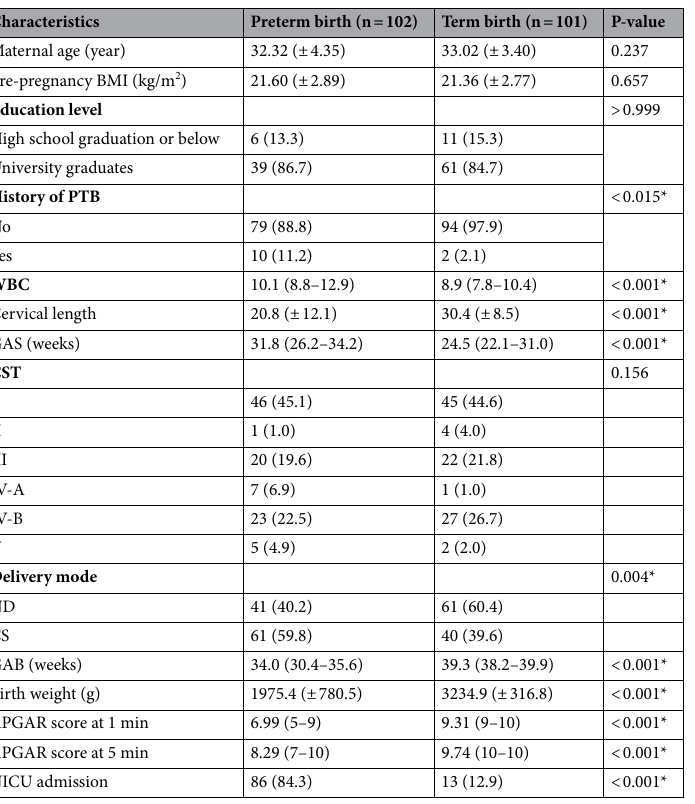
Table 1. Clinical characteristics of the study subjects. Categorical variables were expressed as frequencies (percentage) and analyzed using the chi-square test and Fisher’s exact test. Continuous variables were expressed as the mean ± standard deviation (SD) or median (interquartile range) and were compared using the t -test or Mann–Whitney U test. BMI body mass index, PTB preterm birth, WBC white blood cell, GAS gestational age at sampling, CST community-state type, ND normal delivery, CS cesarean section, GAB gestational age at birth, APGAR appearance, pulse, grimace, activity, respiration, NICU neonatal intensive care unit. *Statistical significance was defined as P <